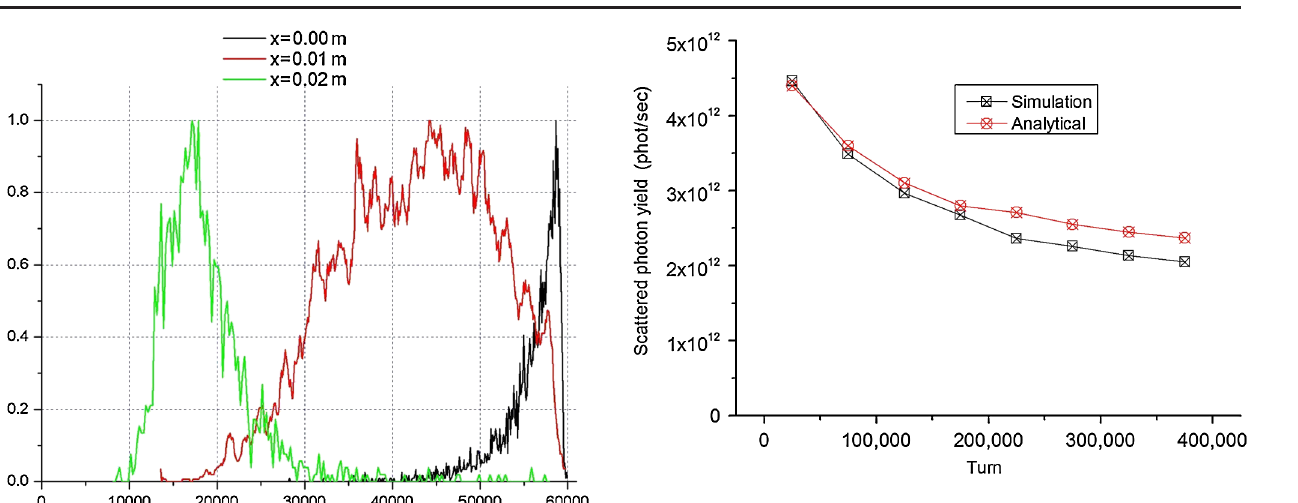
FIG. 9. (Color) The temporal distribution of the total yield of the x-ray photons. We compared the simulation result with that of the analytical one, and they agree well with each other. Owing to the strong IBS effect, the total yield decreases to about 40% of the value at the